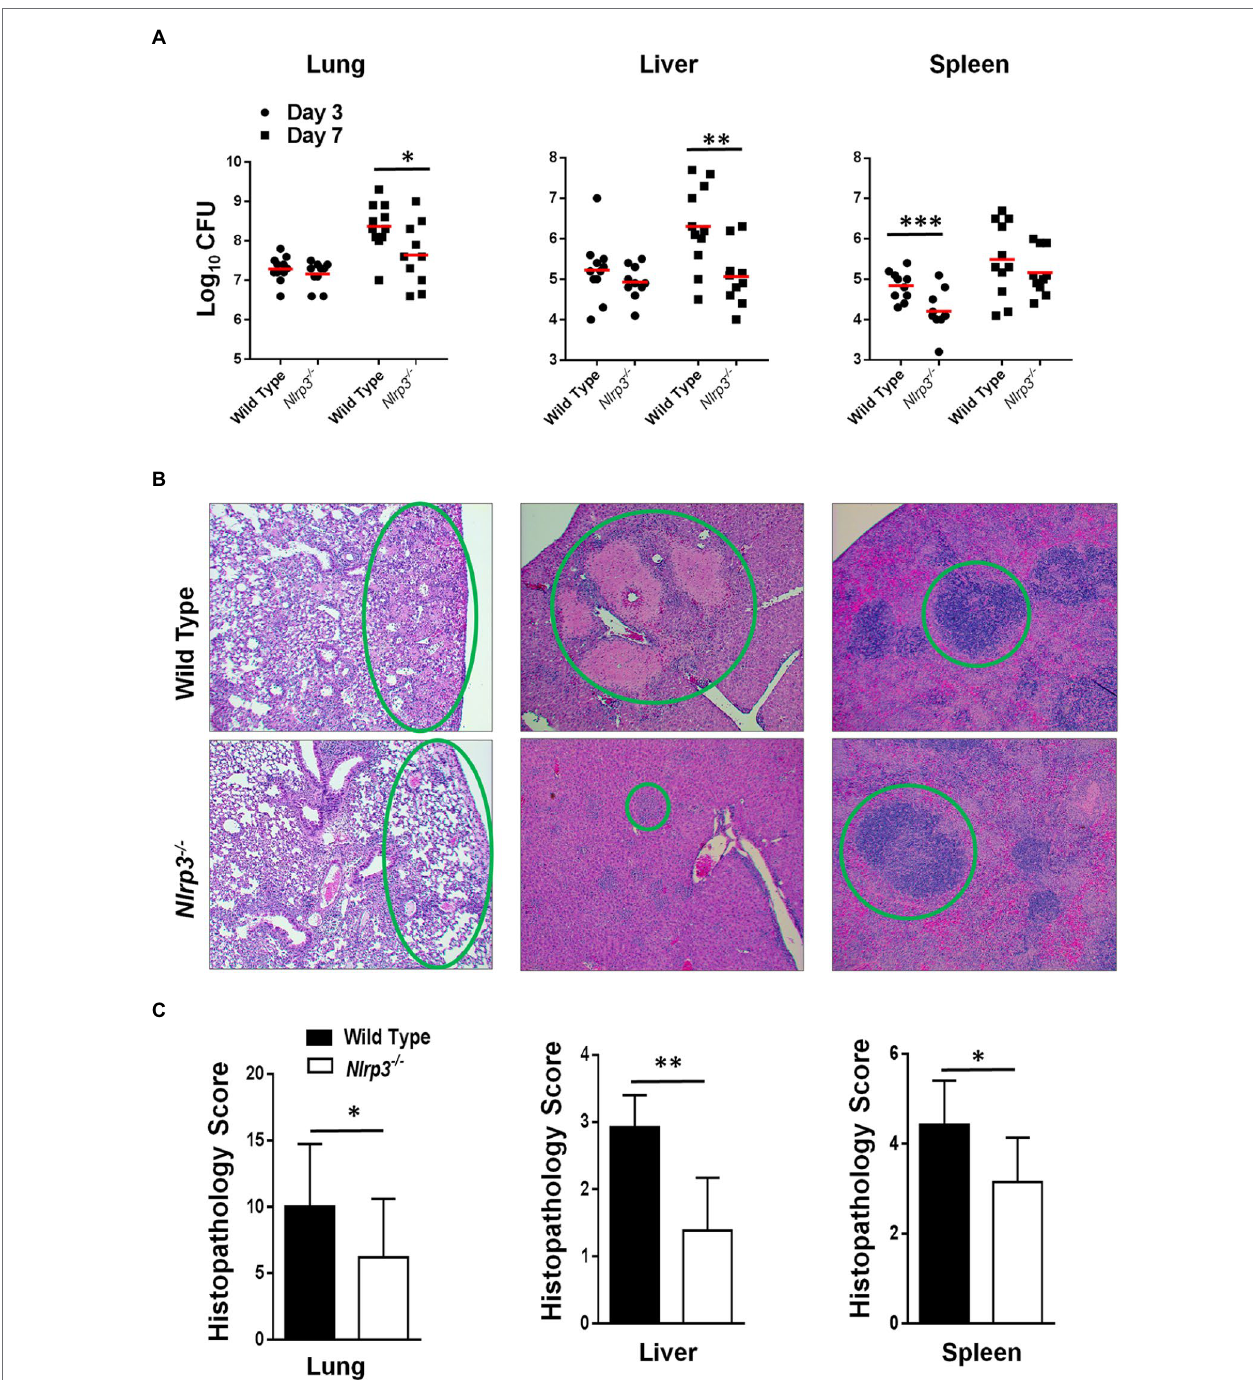
FIGURE 5 | Nlrp3 deficiency results in enhanced bacterial clearance and less severe histopathological lesions in mice infected with F. tularensis LVS. C57BL/6 wild-type and Nlrp3 − / − mice-infected intranasally with 1 × 10 4 CFUs of F. tularensis LVS. (A) The mice were euthanized on days 3 and 7 post-infection and bacterial burdens were quantified in their lung, liver, and spleen. The data shown are cumulative results from three independent experiments ( n = 3–4 mice each/experiment, 11 total/time point). The data were analyzed by ANOVA with the Tukey-Kramer test, and a value of p of 0.05 or less was considered significant. ** p < 0.01; *** p < 0.001. (B) The lung, liver, and spleens were fixed in 10% formalin, paraffin-embedded, sliced into 5 μ M sections, and stained with Hematoxyline and Eosin. Stained sections from mice infected with F. tularensis LVS on day 7 post-infection were observed for histopathological lesions under a light microscope (Magnification 100×). The green circles compare the extent of the lesions between wild-type and Nlrp3 − / − mice. (C) The histopathological damage in the lung, liver, and spleen was quantitated in a blinded fashion by scoring one field of view at a time. Data shown are cumulative scores from three mice and were analyzed by unpaired t -test. * p > 0.05; ** p > 0.01; *** p >